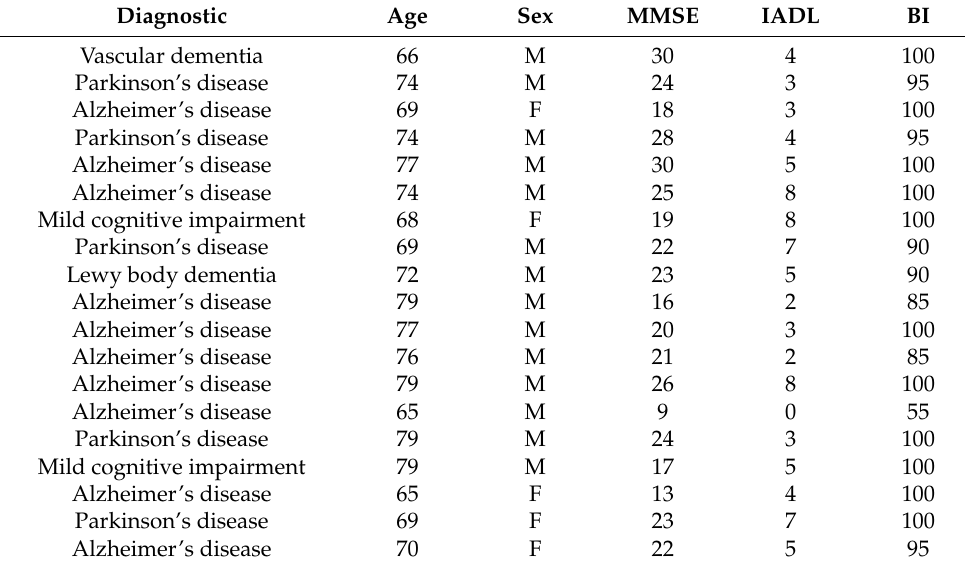
Table 1. Individual characteristics of the